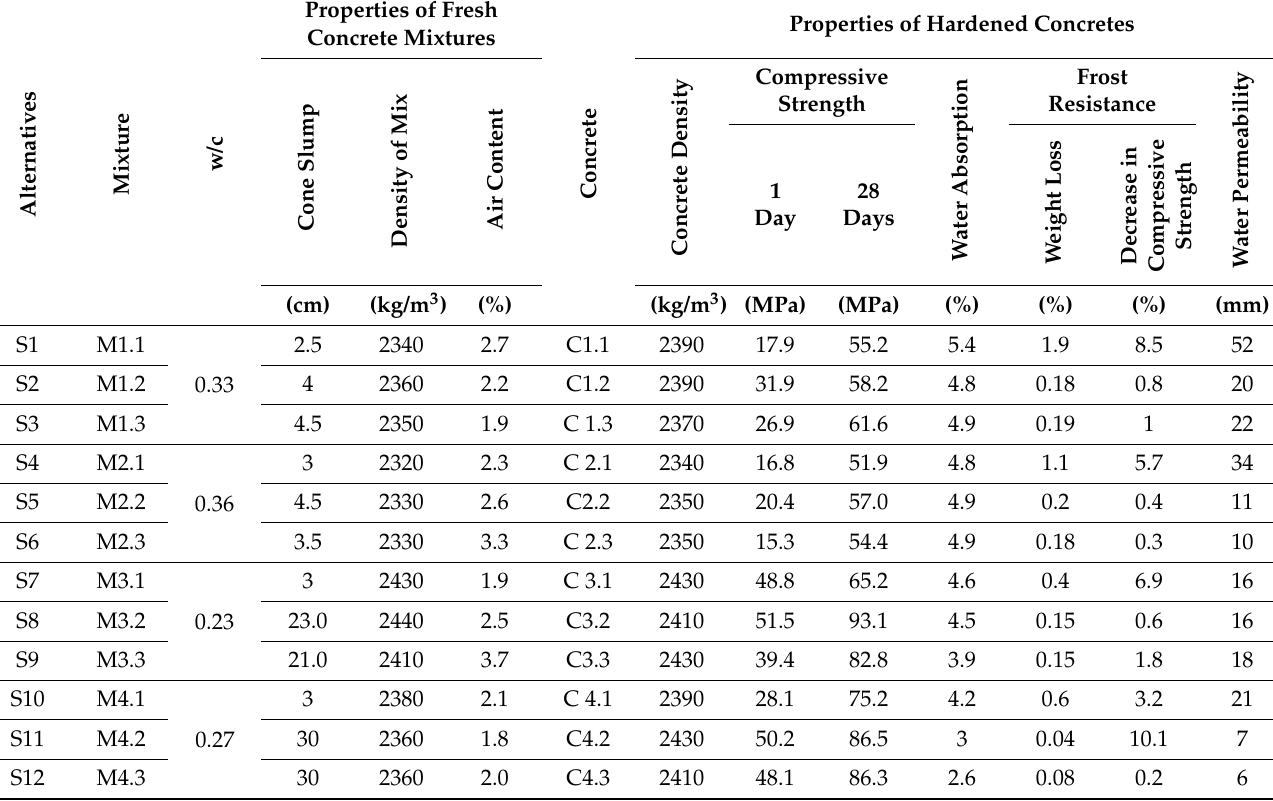
Table 2. Test results of concrete mix and hardened